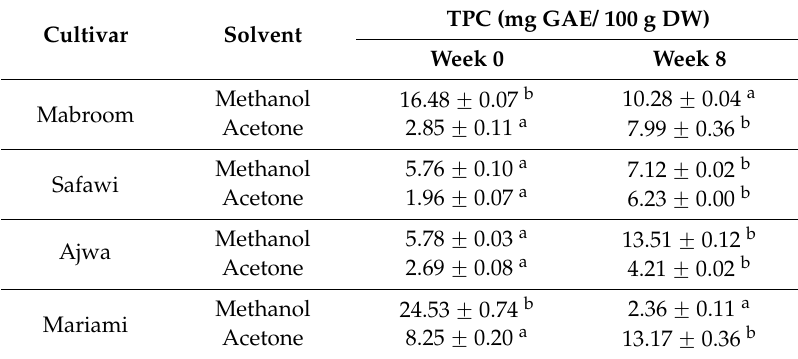
Effects of fruit chilling at 4 ˝ C prior to extraction on the total phenolic content, TPC (mg GAE/100 g DW) in fruits of four different P. dactylifera cultivars were extracted using different